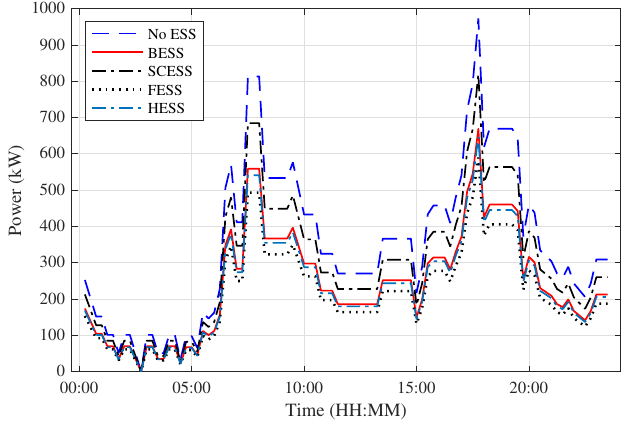
Figure 20. 24 h profile for 45% saving of regenerative braking